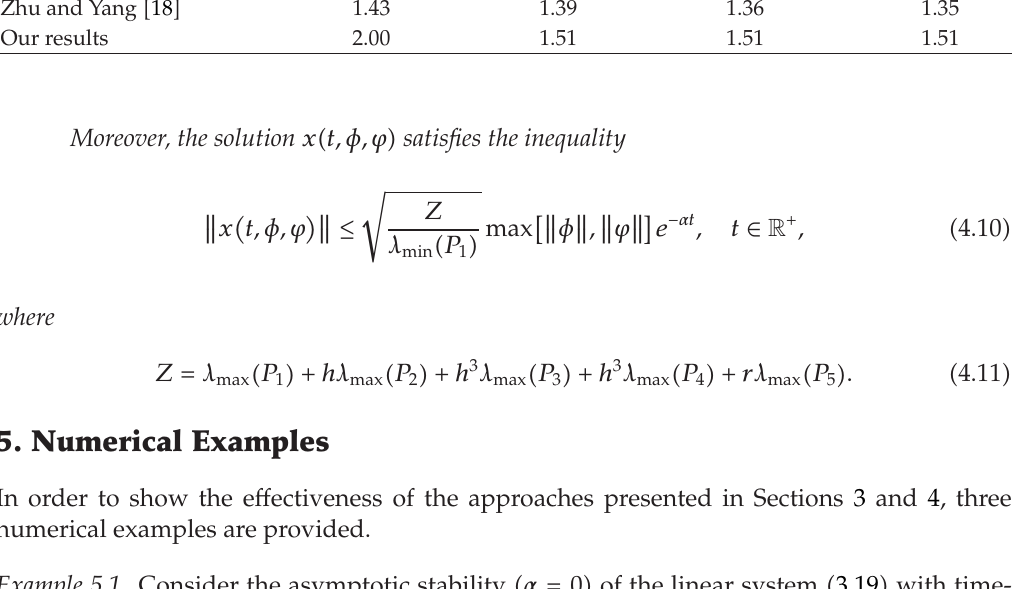
Table 1: Comparison of the maximum allowed time delay h